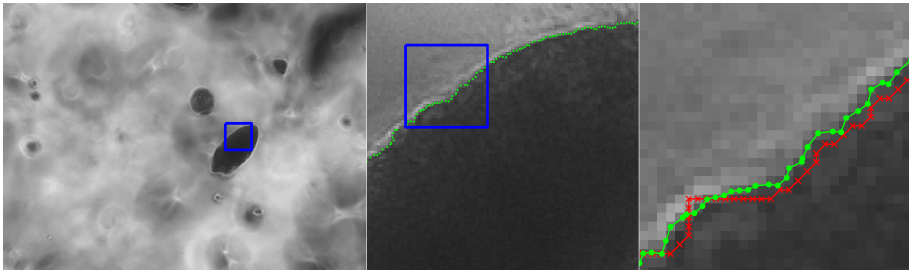
Figure 17. Microscope image from an in vitro tumor model embedded in a hydrogel. We seek to localize the edges of tumors to measure their growth over time [34,35]. The red edge estimates and green dots denote the refined subpixel localization estimates. The original image is courtesy of Dr. Kristen Mills of Rensselaer Polytechnic